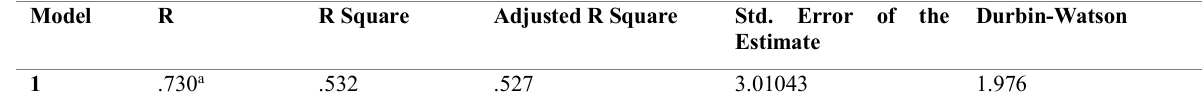
Table 3: Coefficient of